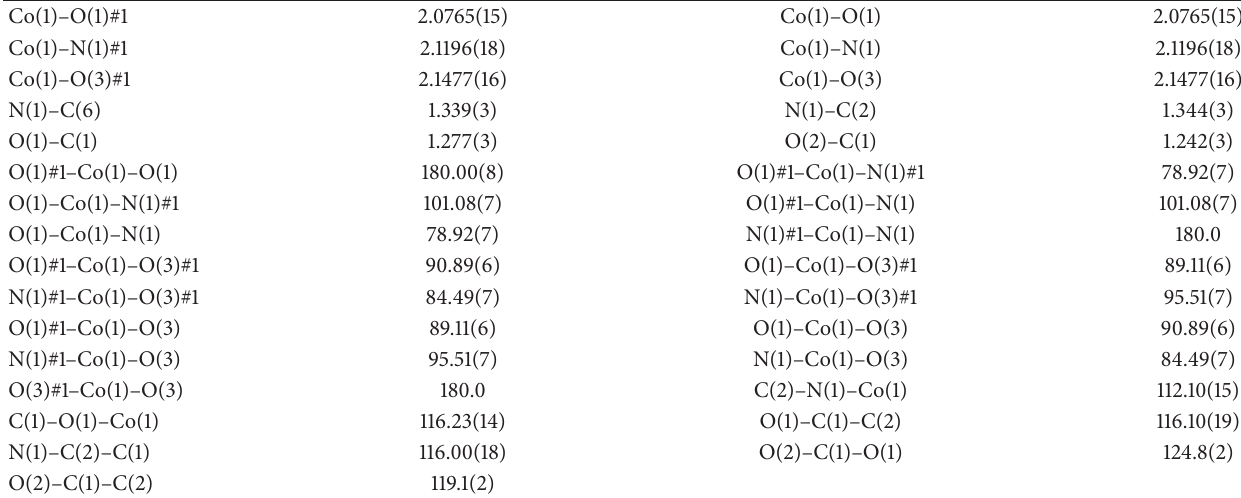
Table 2: Selected bond lengths (˚A) and angles ( ∘ ) for the title complex.